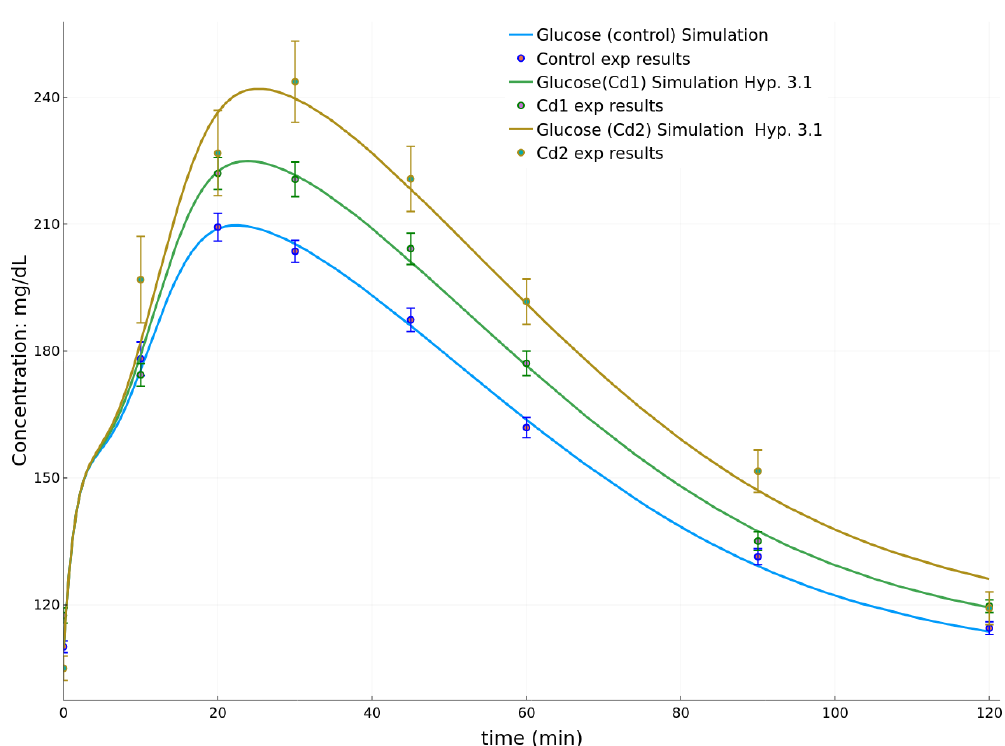
Figure 4. Simulations of the OGTT at PND21 for the control group, Cd1 and Cd2